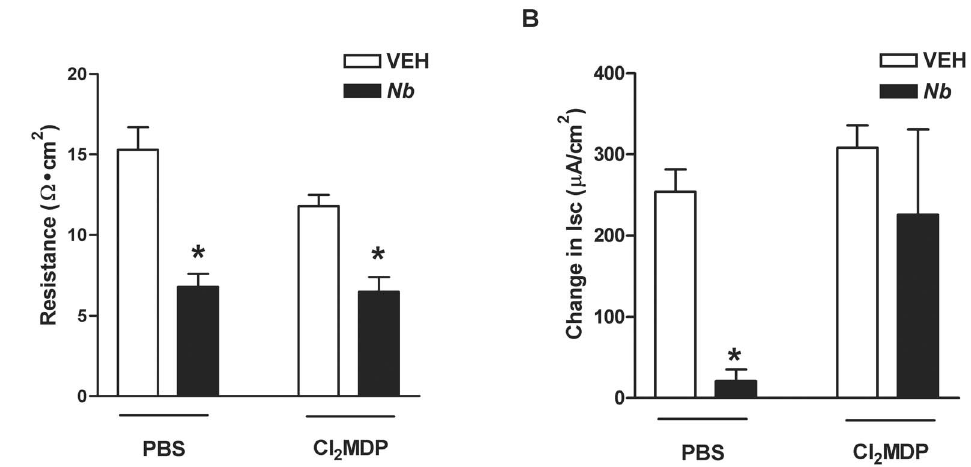
Figure 1. Macrophage depletion improves the N. brasiliensis -induced decrease in glucose absorption, but not in epithelial resistance. WT mice were given PBS or clodronate (Cl 2 MDP) containing liposomes to deplete macrophages and one day later treated with vehicle (VEH) or infected with N. brasiliens is (Nb). At day nine post inoculation, muscle-free mucosae were mounted in Ussing chambers to determine (A) mucosal resistance and (B) concentration dependent changes in epithelial sodium-linked glucose absorption. Values shown are means 6 SE; *p , 0.05 vs VEH Control.